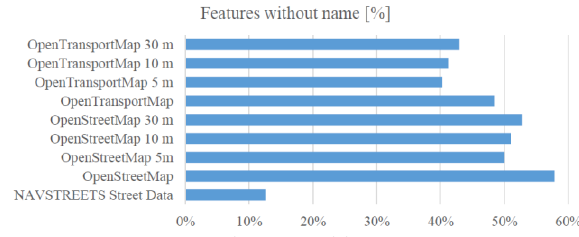
Figure 4: Comparison of number of features without a name, as percentage.